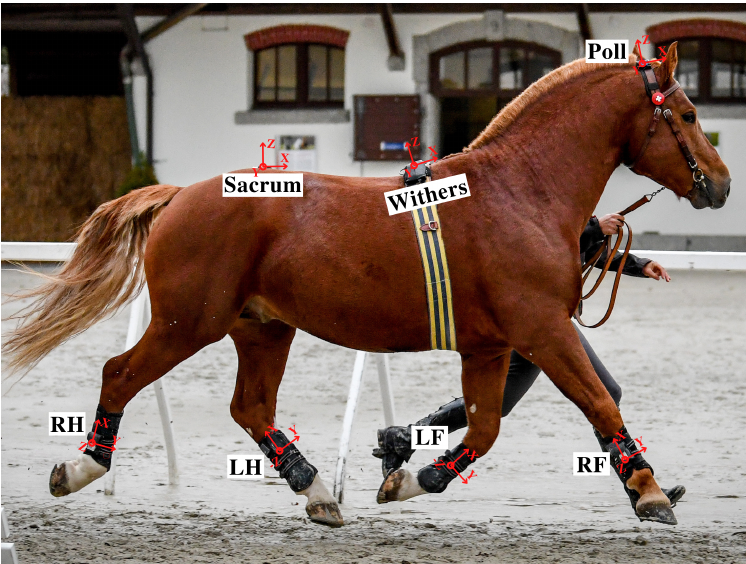
Figure 2. IMUs locations and orientations on horse body. RF: right front limb, LF: left front limb, RH: right hindlimb, LH: left hindlimb. Photographed by Christelle